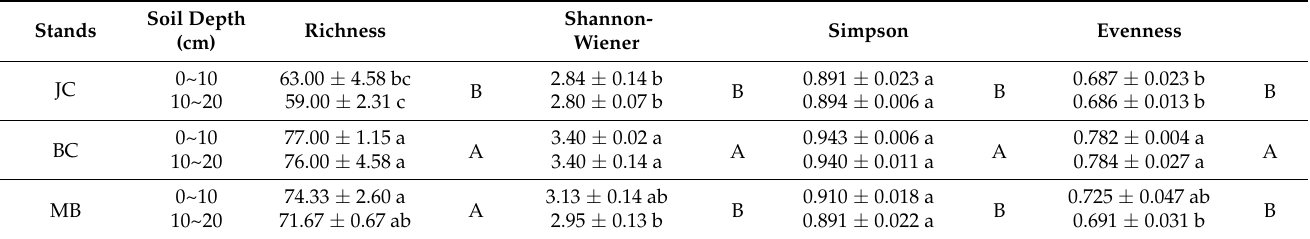
Table 2. The richness and α diversity of the soil AMF community.